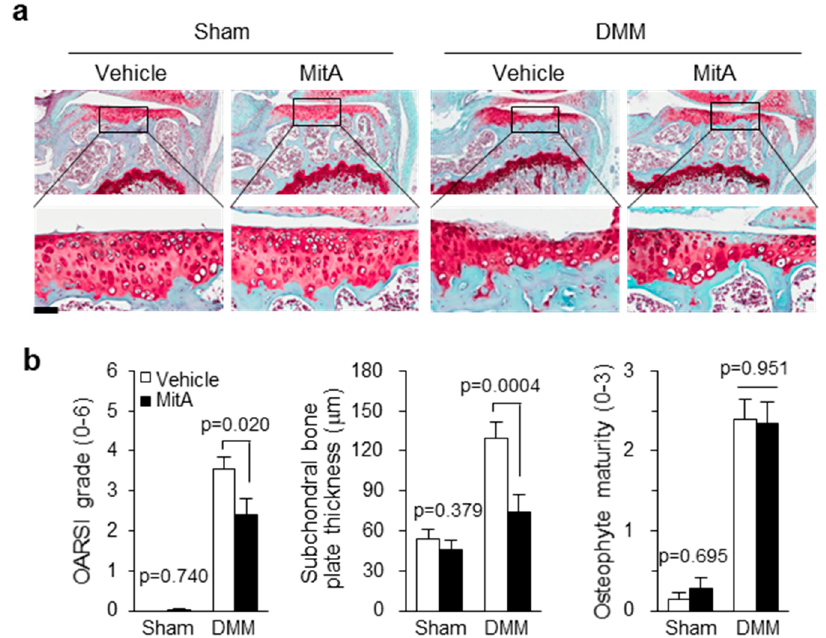
Figure 2. MitA injection to mouse knee joints alleviates post-traumatic OA. 10-week-old male mice operated by DMM surgery were treated with MitA through intra-articular (IA) injection. Mice were harvested 8 weeks later after surgical destabilization of the medial meniscus (DMM). Representative images of safranin-O staining ( a ) and OA-related parameters including OARSI grade, sclerosis, and osteophyte maturity are shown ( b ; n = 12). Values are means ± SEM. Scale bar: 50 μ